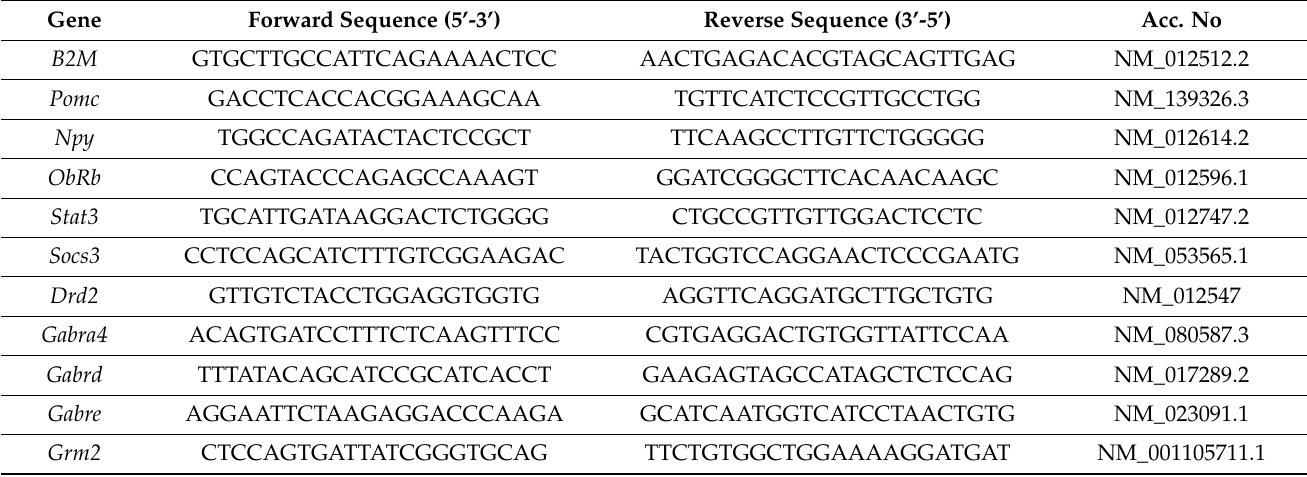
Table 1. Primer sequences of target